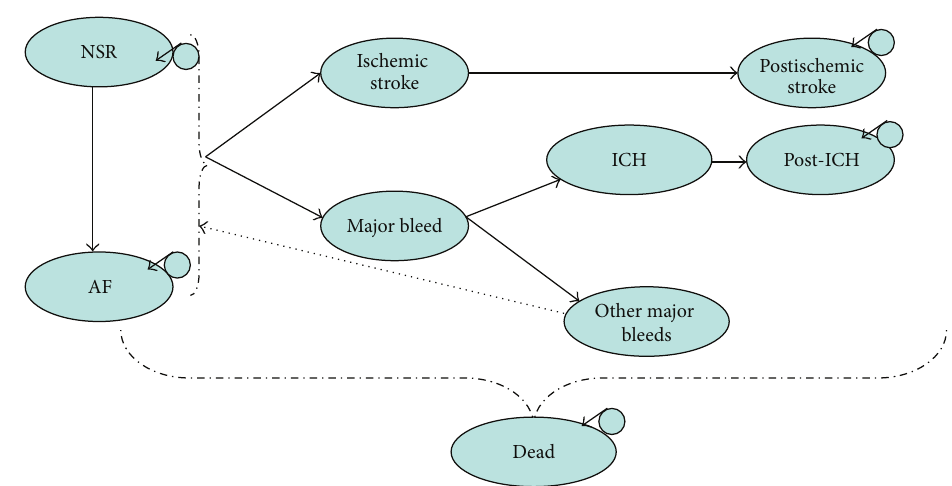
Figure 1: Structure of Short term model.